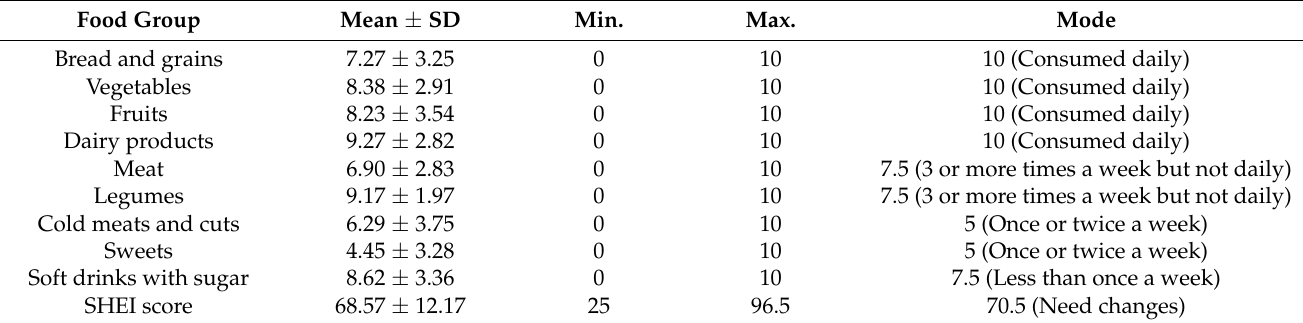
Table 2. SHEI scores of the participants ( n =